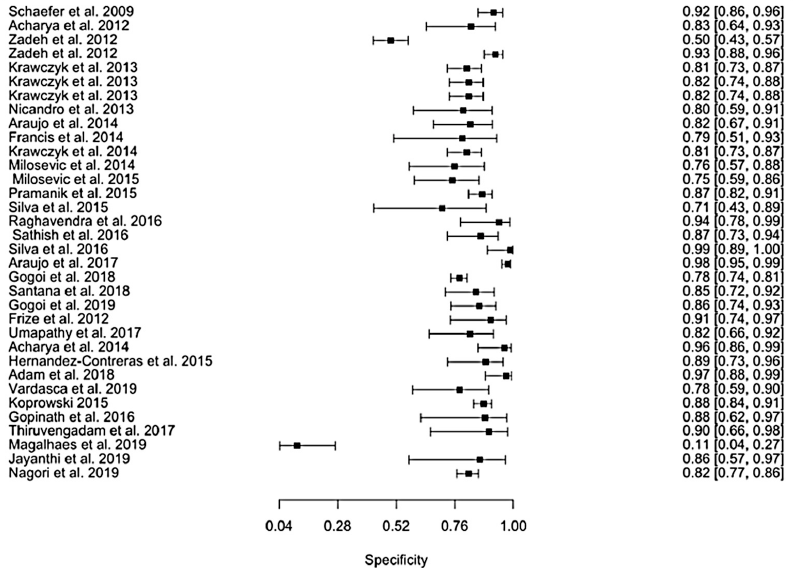
Figure 3. Forest plot for specificity: all studies combined.